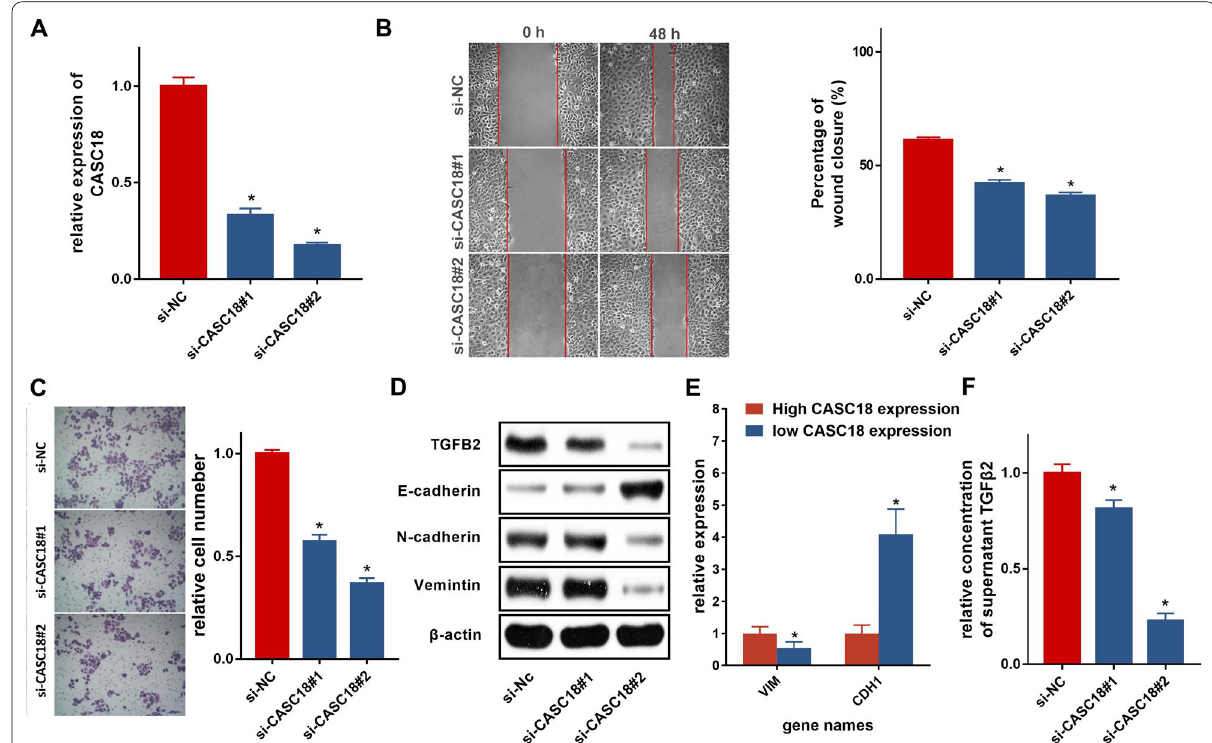
Fig. 5 Silencing CASC18 inhibits CAL27 cell migration and invasion through repressing TGFB2-mediated EMT A The silencing of CASC18 was conducted with the transfection of si-CASC18#1 and si-CASC18#2, as compared with si-NC. Representative photos of B wound healing and C assays indicate the role of CASC18 RNAi in cell migration and invasion. The right histograms denote the percentage of wound closure and the relative number of invaded cells, respectively. The impact of CASC18 knockdown on the D expressions of TGFB2, E-cadherin, N-cadherin, Vimentin by western blotting analysis with the reference of β-actin. E The mRNA levels of VIM and CDH1 genes were detected by qRT-PCR in two groups of clinical samples carrying high or low CASC18 expression. F The impact of CASC18 knockdown on the secretion of TGFB2 by ELISA. Data are presented as the mean SD. *p < ±